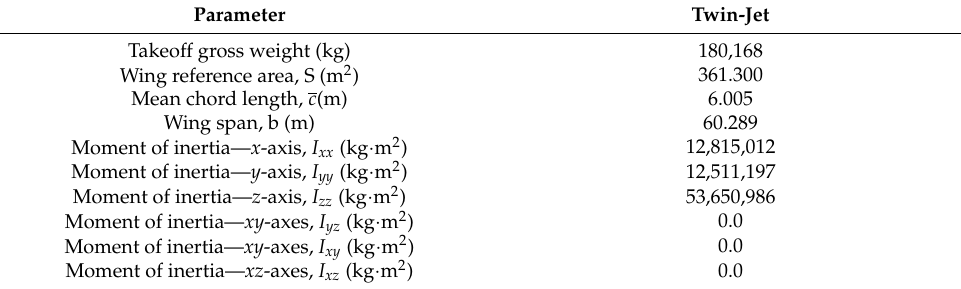
Table 1. Main geometry and moment of inertia data for the twin-jet transport